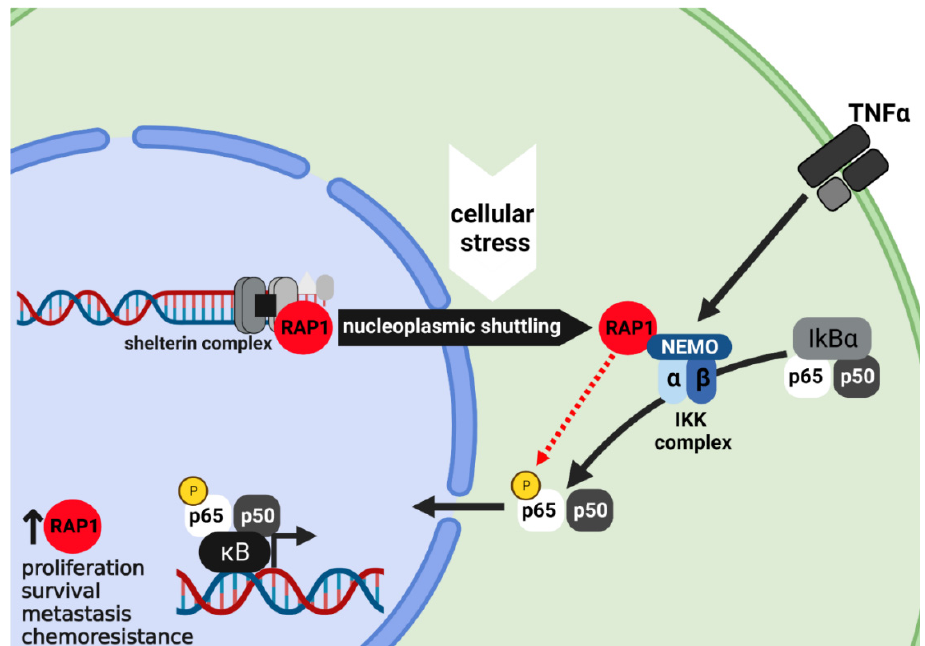
Figure 3. Schematic representation showing the role of RAP1-enhanced activation of NF- κ B signaling. In cancer cells under extreme conditions, such as oxidative stress, RAP1 shuttles from nucleus to cytoplasm, where RAP1 forms a complex with IKK complex. RAP1–IKK interaction is essential for phosphorylation of the p65 subunit at Ser 536 (red dotted arrow) to make it transcriptionally competent. RAP1-mediated activation of NF- κ B can stimulate transcription of genes involved in inflammation, proliferation, tumor survival, metastasis, and chemoresistance. Moreover, activation of NF- κ B is correlated to an increase in RAP1 levels. Created with BioRender.com (accessed on 6 October 2021).